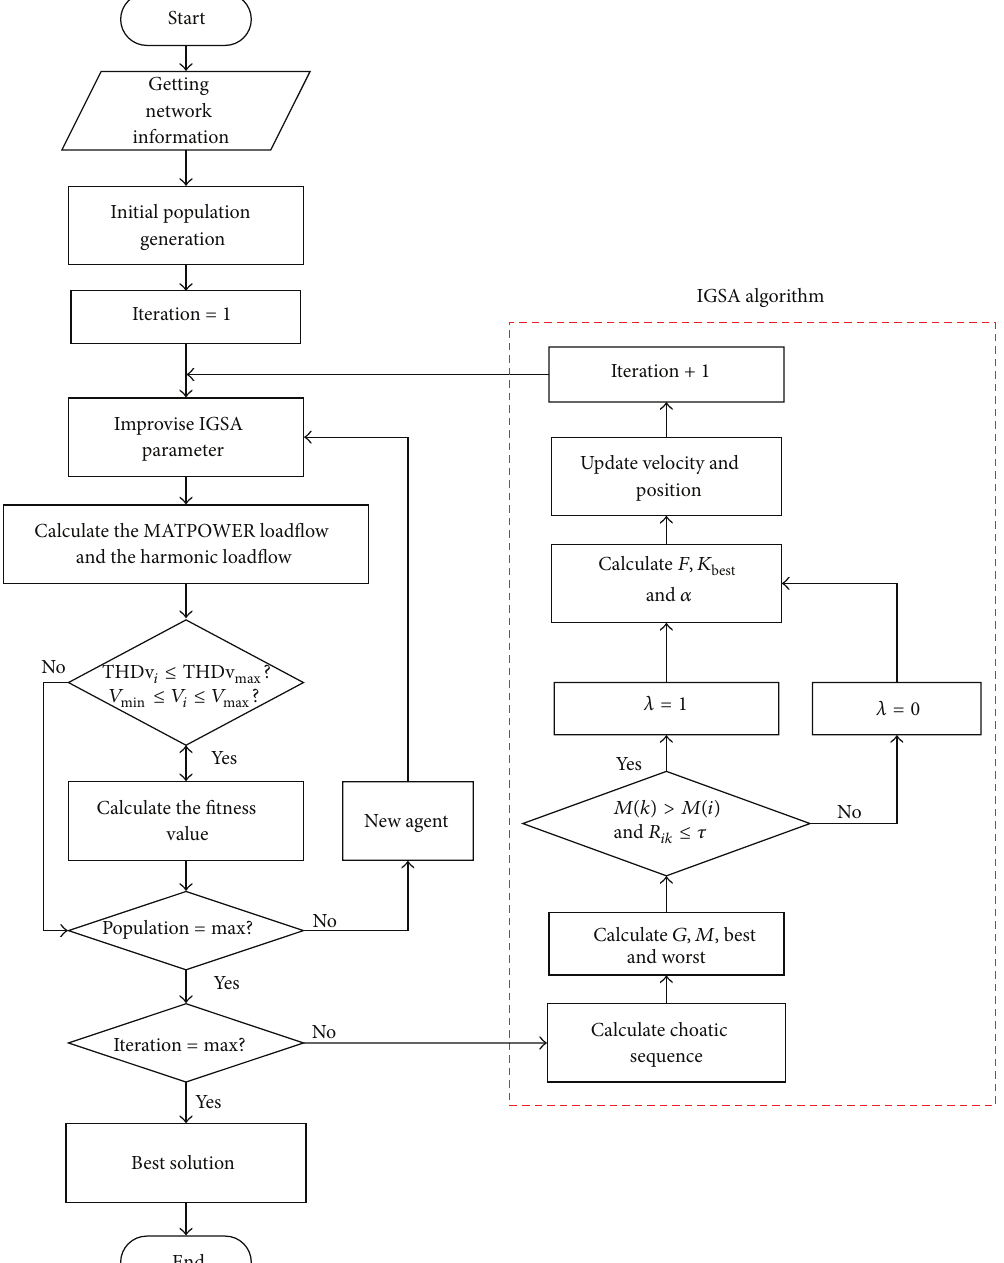
Figure 2: Flowchart of the general optimization technique for determining optimal placement and sizing of PVDG in a distribution system.